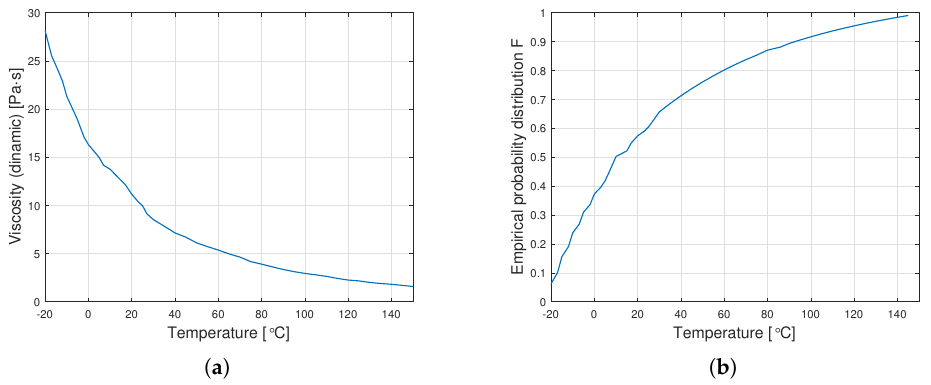
Figure 5. Transition from data on dynamic viscosity to the distribution function ( a ) graph of em- pirical dynamic viscosity for an oil with a nominal kinematic viscosity of 10,000cSt, ( b ) empirical distribution function.